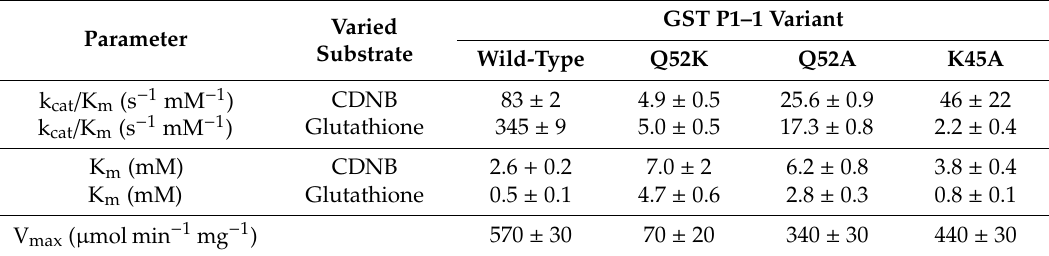
Table 2. Steady-state kinetic parameters of wild-type human GST P1–1 and mutants. Varied Parameter